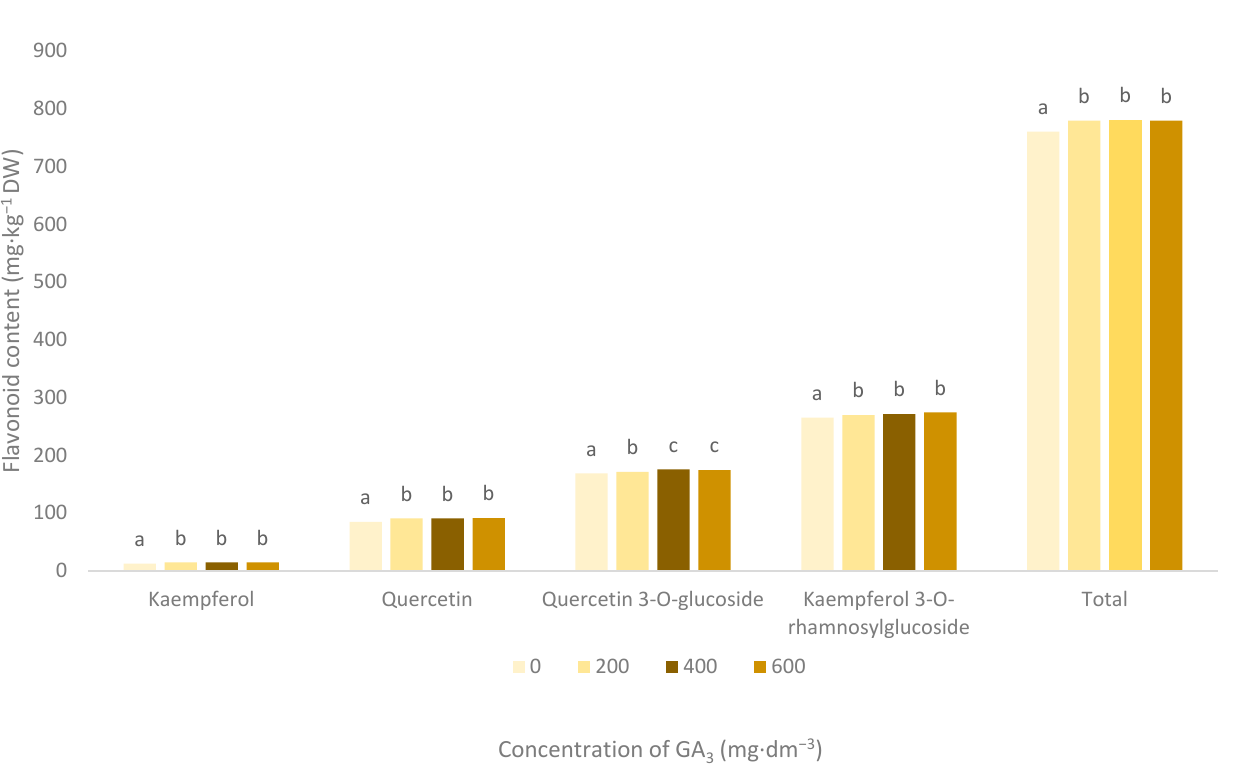
Figure 3. Flavonoid content of the Crocosmia × crocosmiiflora ‘Lucifer’ tubers after application of GA 3 . Means followed by the same letter do not differ significantly at α = 0.05.